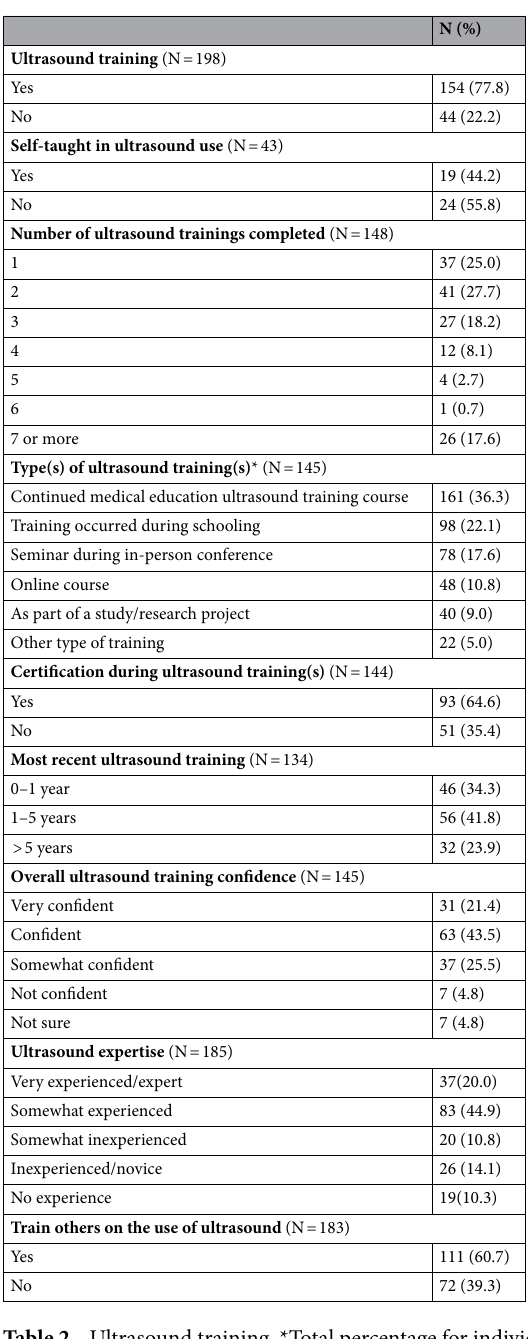
Table 2. Ultrasound training. *Total percentage for individual question may be over 100% due to “Check all that apply” option for that question on the survey. The value for N provided for “Check all that apply” questions represents the number of